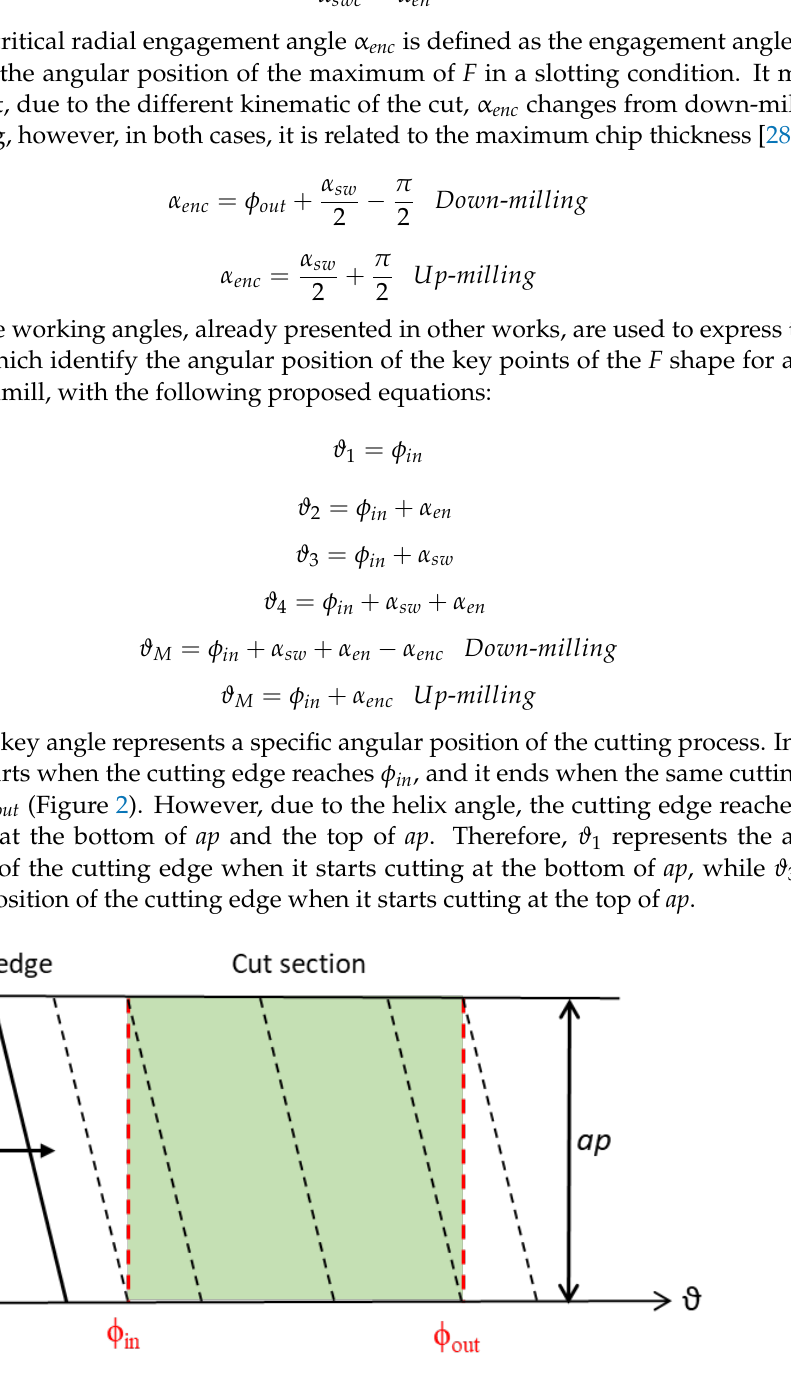
Figure 2. Schematic diagram of cutting edge’ locations during the cutting process (black dashed lines represent the cutting edge at the different key positions).